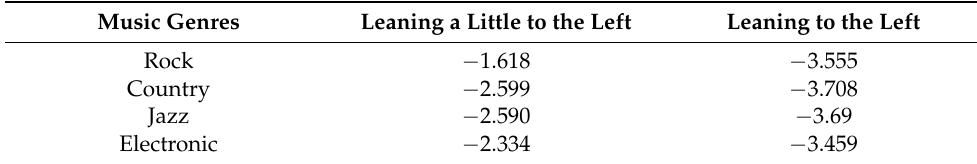
Table 2. Objective listening